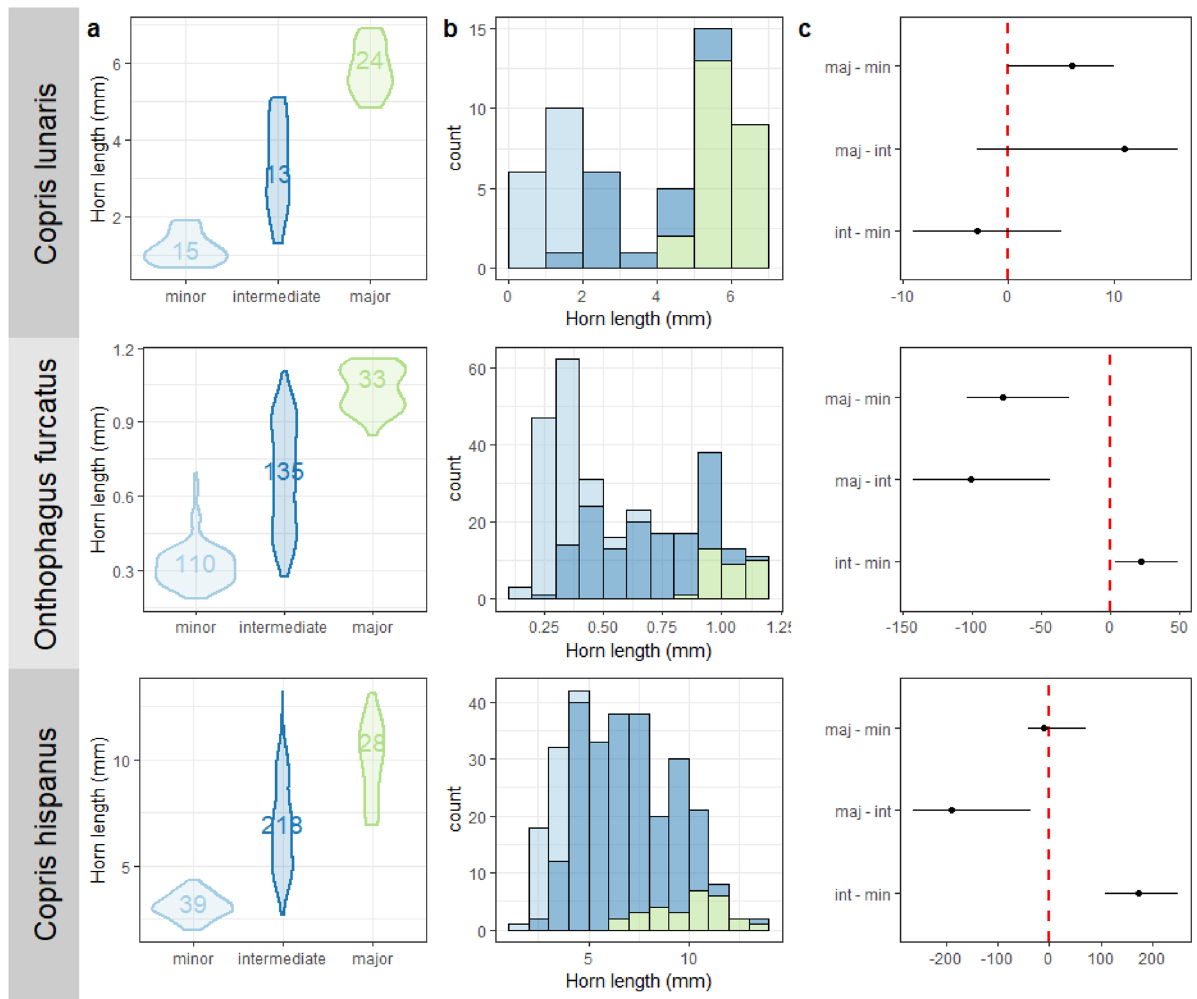
Figure 2. Occurrence of minor, intermediate, and major individuals in three dung beetle species. ( a ) Violin plot of the horn length of the minor (light blue), intermediate (blue), and major (green) groups for three dung beetle species. The number of individuals in each group is also reported; ( b ) histograms of the horn length divided by group; ( c ) confidence intervals of the difference among the number of individuals in the minor, intermediate, and minor groups. The median values (black circles) and 95% percentile intervals (solid lines) of differences are reported. The dashed red lines indicate Slope parameter b in the sigmoidal equation was 34.1, 24.1 and 11.5 for C. lunaris , O. furcatus, and C. hispanus , respectively. No apparent discontinuities were found by visual inspection or in log–log plots of the body size- horn length relationship (Supplementary 2). We performed a changepoint analysis to identify the number of individuals in minor, intermediate, and major groups. The number of individuals and the body size range (i.e. the difference between maximum and minimum body size) of the intermediate group differed among species (Fig. 2a). Copris lunaris had the fewest individuals (median = 13, 25% of the analysed individuals) and the narrowest body size range of the intermedi- ate group (median = 0.79 mm, 23% of the overall body size range). The intermediate group of O. furcatus was composed of 133 individuals (48%) with a body size range of 0.27 mm (29%), while that of C. hispanus contained 218 individuals (76.5%) with a body size range of 2.9 mm (47.4%). In O. furcatus , the number of observed and simulated individuals in the intermediate group were due to variability introduced with random number generation. The analysed species differed in the horn length dimorphism, with C. lunaris , O. furcatus , and C. hispanus having marked bimodal, weak bimodal, and unimodal distributions, respectively. The recognition of intermediates resulted in less marked bimodal distribution peaks for minors and majors, especially for the majors in O. furcatus (Fig. 2b). We determined the significance of the difference in the number of individuals in minor, intermediate, and major groups by simulating the regression parameters values from the variance–covariance matrix of the parameters using multivariate normal distribution. The number of individuals in the minor, intermediate, and major groups did not significantly differ in C. lunaris (confidence intervals completely overlapped 0; Fig. 2c).